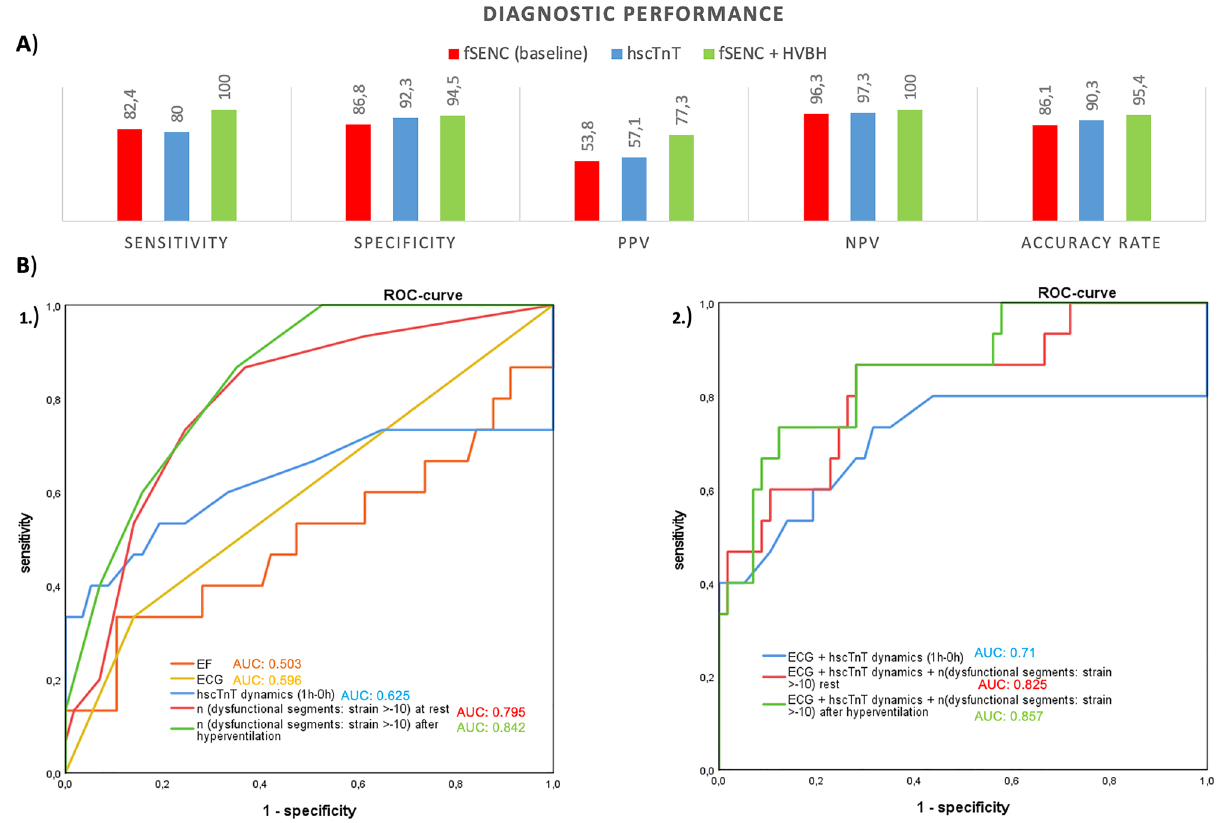
Figure 2. Central illustration of results. ( A ) Comparison of diagnostic performance of fSENC (at baseline) to hscTnT dynamics (1 h–0 h) and fSENC with HVBH. ( B ) ROC curves for ACS identification according to quantifiable markers (EF, ECG (ST-wave abnormalities), hscTnT dynamics, number of dysfunctional segments (strain > − 10) at rest and after hyperventilation) and Logistic regression analysis of combined diagnostic methods: (1) EF (AUC = 0.503; 95% CI 0.31–0.70, p = 0.976), ECG (AUC = 0.596; 95% CI 0.43–0.77, p = 0.271), hscTnT dynamics (1 h–0 h) (AUC = 0.625; 95% CI 0.41–0.84, p = 0.245), number of dysfunctional segments (strain > − 10) at rest (AUC = 0.795; 95% CI 0.67–0.92, p < 0.0001) and number of dysfunctional segments after hyperventilation (AUC = 0.842; 95% CI 0.75–0.94, p < 0.0001). Comparison of ROC curves: EF vs. n(ds